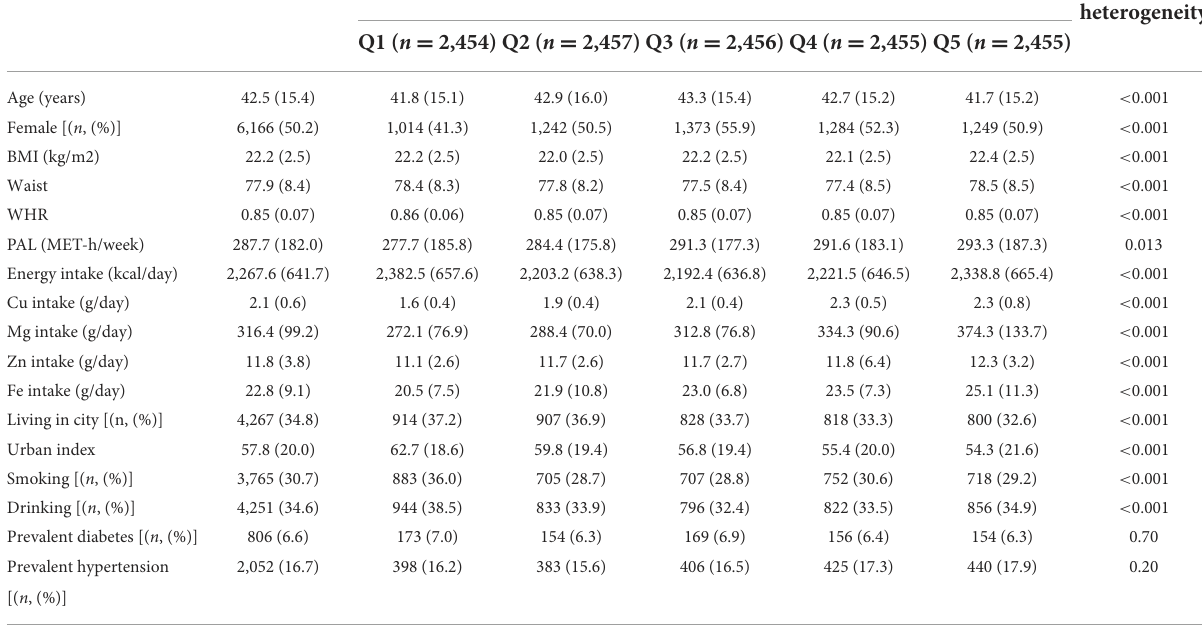
TABLE 1 Baseline characteristics of study participants by quintiles of cumulative dietary copper intake in general obesity analysis. Baseline variable All ( n = 12,277) Quintiles of cumulative dietary copper intake P